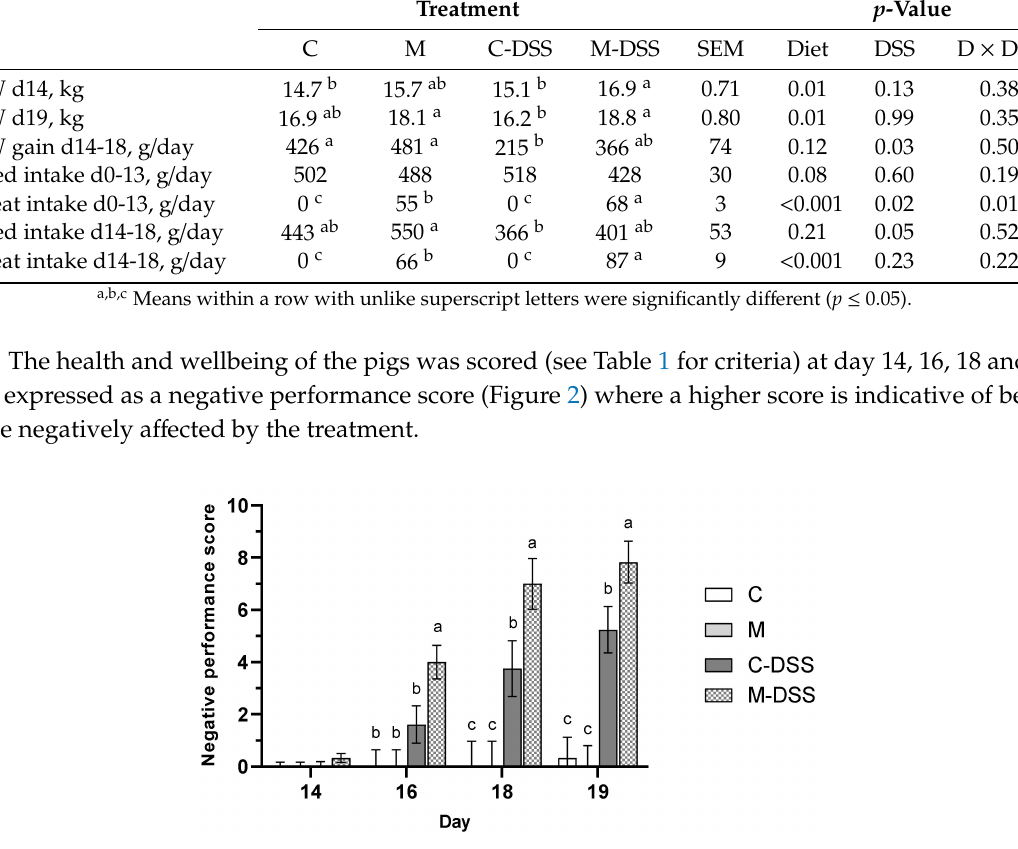
Figure 2. Negative performance score on day 14 to 19 for pigs receiving the control diet (C), the meat diet (M), the control diet + DSS (C-DSS) or the meat diet + DSS (M-DSS) ( n = 6 / group, except C-DSS n = 5). Data are presented as least square (LS) means ± SEM. Di ff erent letters (a, b, c) indicate a significant e ff ect of treatment within day ( p ≤